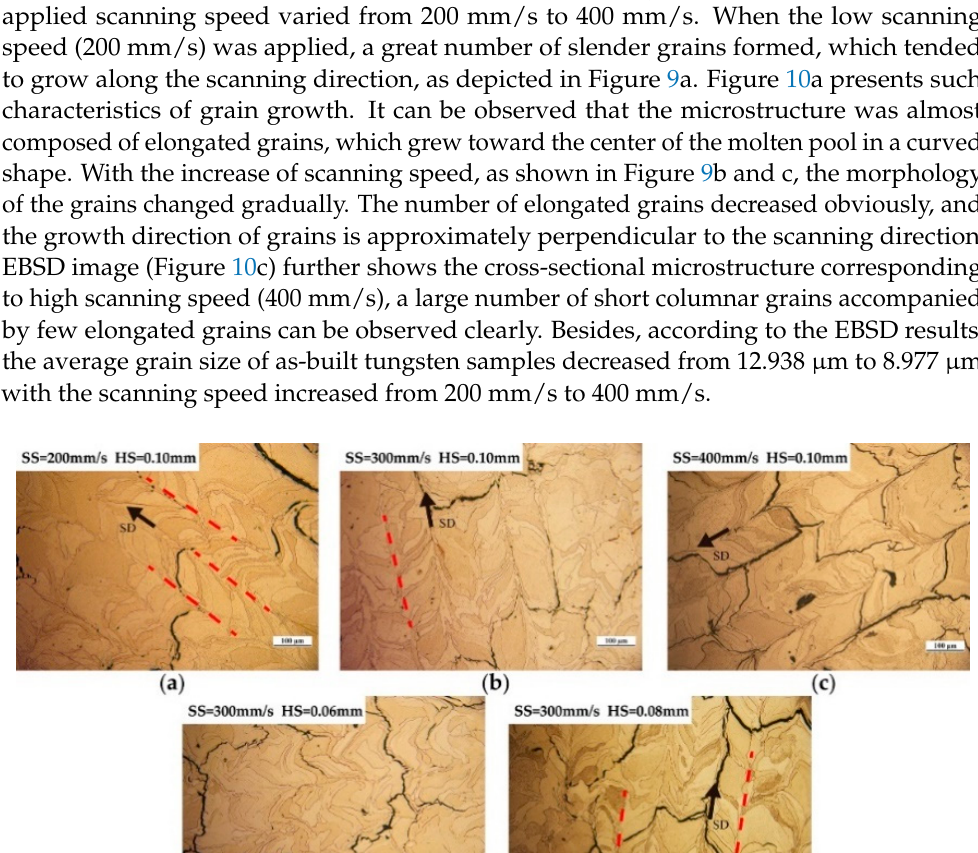
Figure 10. Electron backscattered diffraction (EBSD) images of the cross-section at different scan- ning speeds and hatch spacing. ( a ) T21, ( b ) T24, ( c ) T27, ( d ) T22. In addition to the scanning speed, the effect of hatch spacing on the microstructure of as-built tungsten samples was also discussed. Figure 9b,d,e give the cross-sectional micro- structure under different hatch spacing when the same scanning speed (300 mm/s) was used. As can be seen in Figure 9d, the boundaries of the molten pool became indistinguishable when the low hatch spacing (0.06 mm) was used. With the increase of hatch spacing, the boundaries of the molten pool became distinguishable, as shown in Figure 9b,e. This phe- nomenon can be attributed to the excessive re-melting between adjacent tracks. In addition, tungsten grains with irregular morphology were distributed randomly in the cross-section and can be observed in both Figures 9d and 10d. The morphology of the tungsten grains did not change significantly with the variations in hatch spacing. Also, the average grain size corresponding to hatch spacing of 0.06 mm, 0.08 mm, and 0.10 mm was 11.914 μ m, 12.189 μ m, and 10.541 μ m, respectively. It can be noted that the hatch spacing had no obvious effect on the grain size of as-built tungsten samples. The difference in morphology and size of grains can be explained by different solidifi- cation conditions caused by the different process parameters used in the LPBF process. As illustrated in Figure 11a,b, it can be found that the shape of the molten pool shifted from slightly elliptical to teardrop shaped with the increase of scanning speed. During the solid- ification process, the formed grains tended to grow along the direction of the maximum